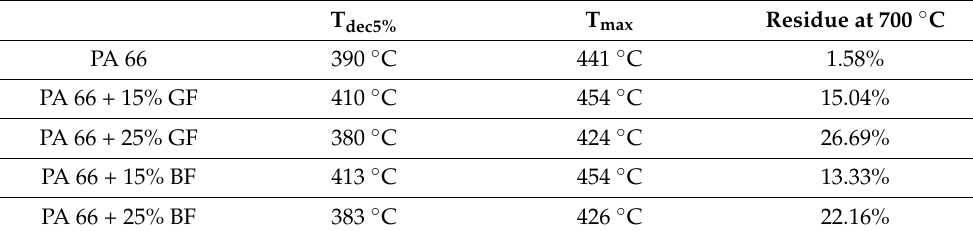
Table 1. Initial decomposition temperature (T dec5% ), temperature of the maximum rate of decomposi- tion (T max ), and residue at 700 ◦ C for the PA 66-based compounds. T dec5%